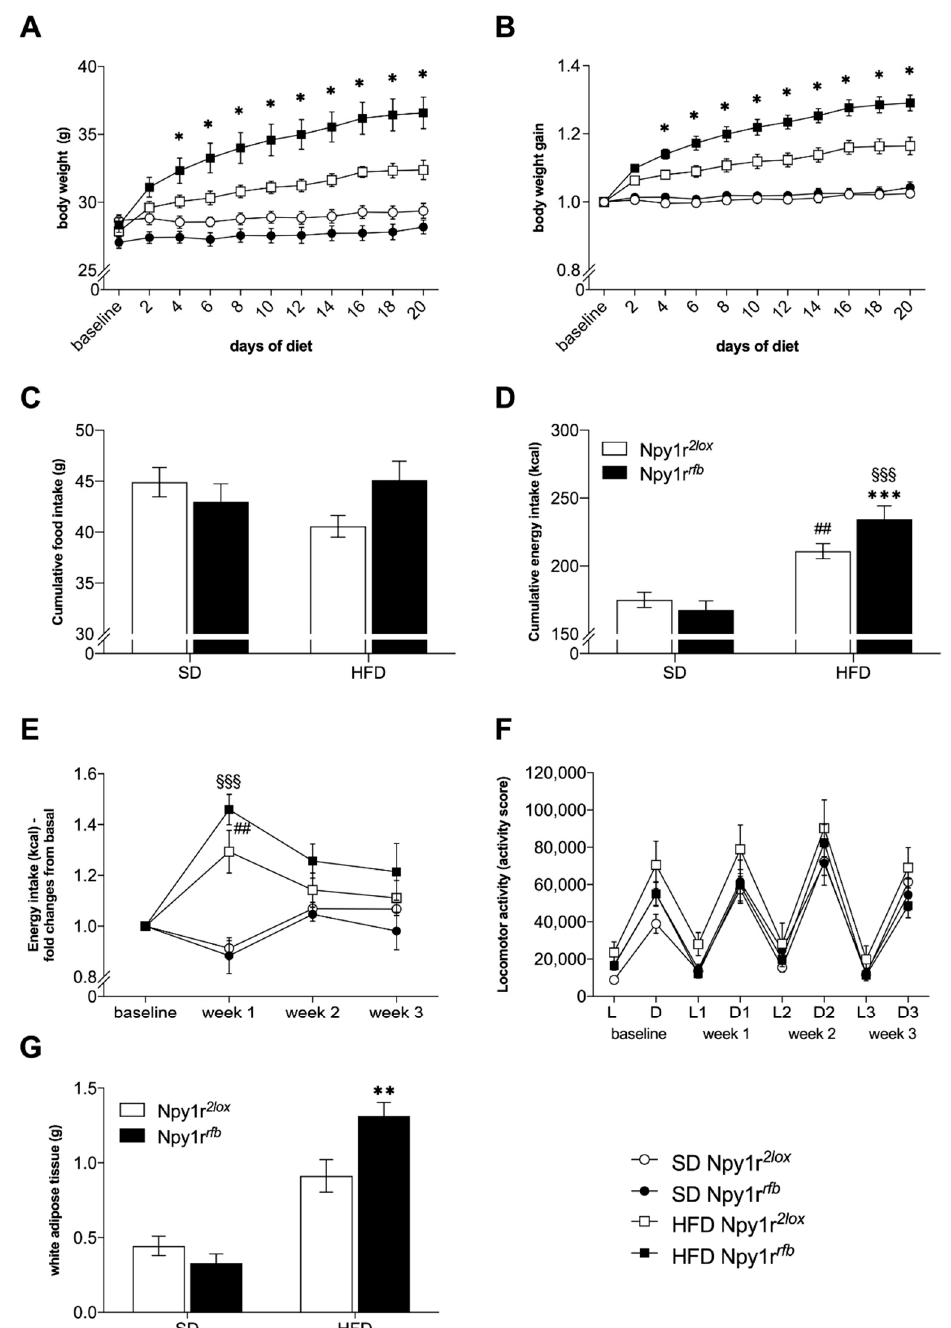
Figure 3. Metabolic consequences of HFD in Npy1r 2lox and Npy1r rfb male mice. ( A ) Body weight growth, ( B ) body weight gain , ( C ) cumulative food intake (g), ( D ) cumulative energy (kcal) intake and ( E ) weekly energy intake (kcal) of SD- and HFD-fed Npy1r 2lox and Npy1r rfb mice during the metabolic challenge procedure. ( F ) Spontaneous locomotor activity of Npy1r 2lox and Npy1r rfb male mice exposed to SD or HFD for 21 days. ( G ) White adipose tissue weight (g) of Npy1r 2lox and Npy1r rfb male mice exposed to SD or HFD for 26 days. Data are presented as mean ± SEM. Food intake was calculated as means of the sum of grams for mouse ( C ); energy intake was calculated as means of the sum of kilocalories ( D ) for mouse and as fold changes versus baseline ( E ). ( A,B ): * p < 0.05 versus Npy1r 2lox on HFD; ( D ): *** p < 0.001 versus Npy1r 2lox on HFD, ## p < 0.01 versus Npy1r 2lox on SD, §§§ p < 0.001 versus Npy1r rfb on SD; ( E ): ## p < 0.01 versus Npy1r 2lox on SD, §§§ p < 0.001 versus Npy1r rfb on SD; ( G ) : ** p < 0.01 versus Npy1r 2lox on HFD.